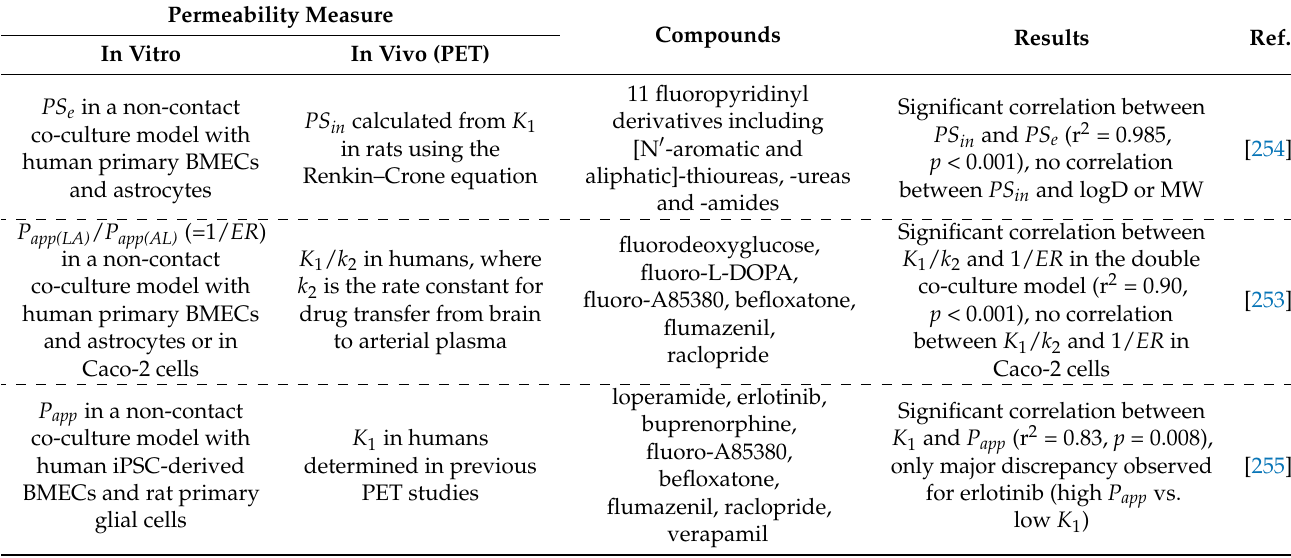
Table A1. Results from studies comparing in vitro permeabilities in static co-culture models with PET-based in vivo